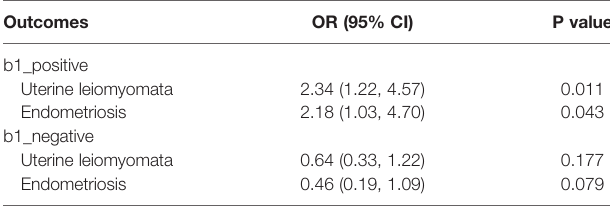
TABLE 3 | WQS model to estimate the association between WQS index and uterine leiomyomata and endometriosis in premenopausal participants (N=1045).